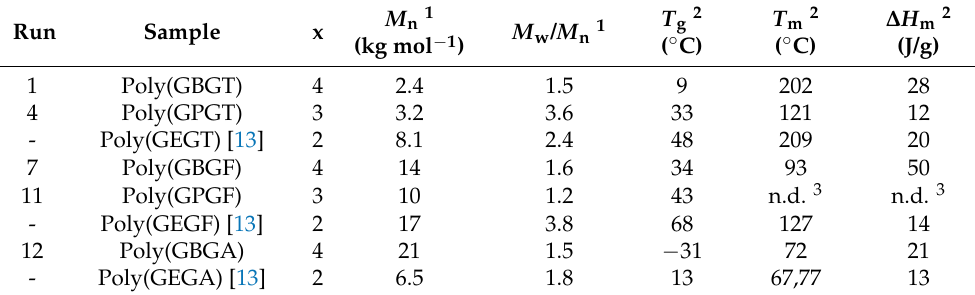
Table 4. Comparison of thermal properties of the sequence-controlled copolyesters having different diol